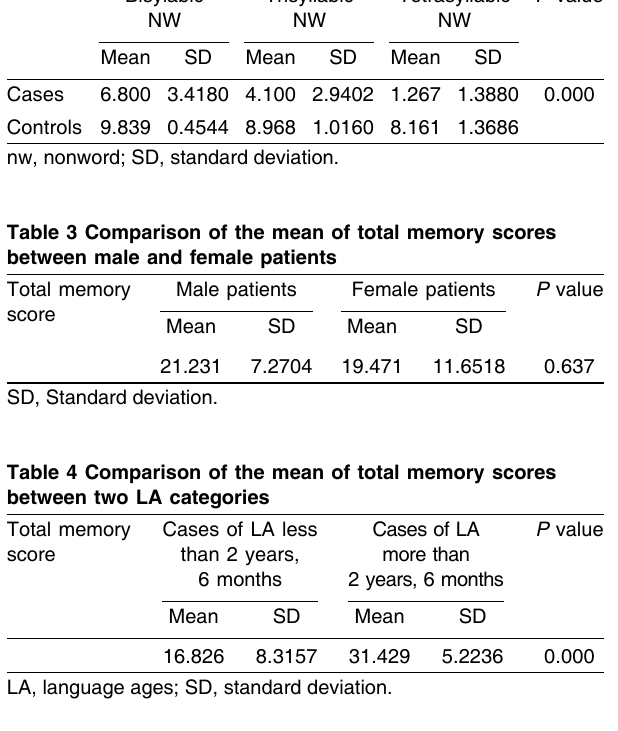
Table 2 Comparison of results of nonword repetition test between cases and controls Bisylabic Trisyllabic Tetrasyllabic NW NW NW